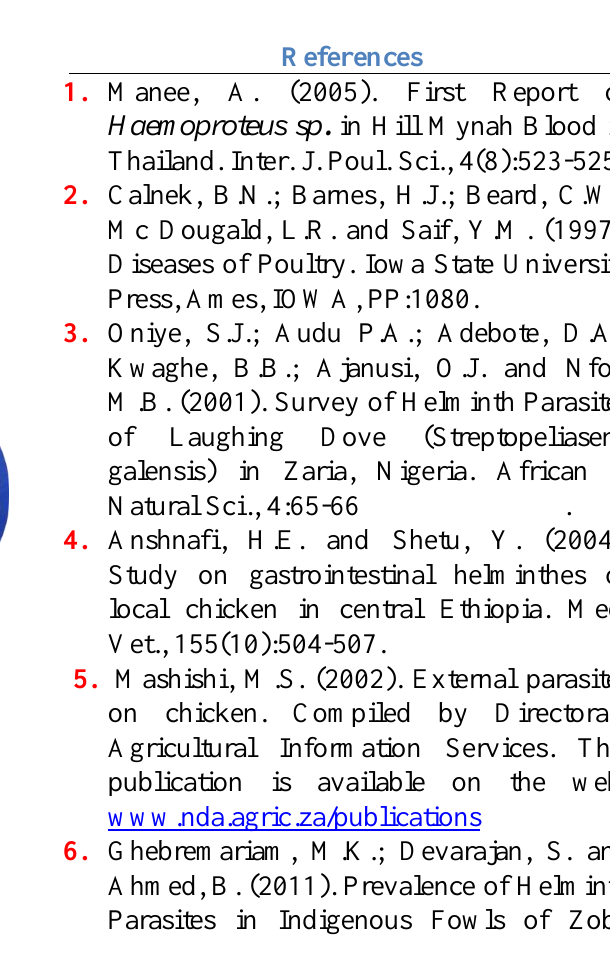
Figure, 7: Scolex of Choanotaenia